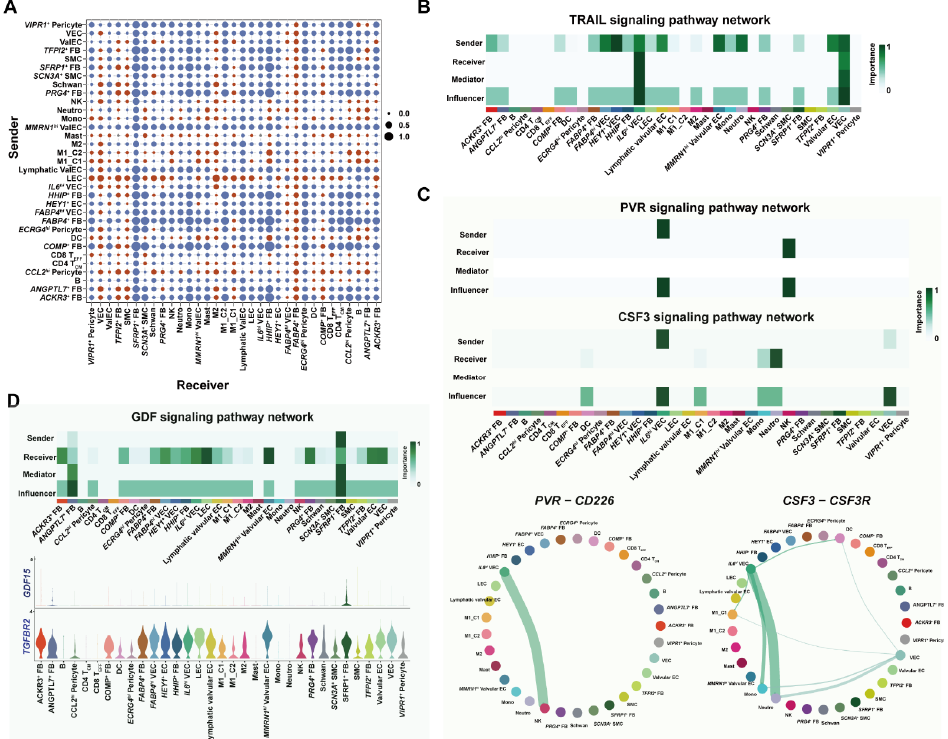
Figure 6. Cell–cell interaction analysis of all cell subsets in human GSV. ( A ) The interaction strengths among all cell subsets were compared between diabetic patient (P2) and nondiabetic patients. Red dots stand for interaction strength that was increased in P2, whereas blue dots are decreased inter- action in P2. ( B ) The plot demonstrates the signaling role of cell subsets in TRAIL signaling, and results imply that IL6 hi VECs were major receivers for this inflammatory pathway. ( C ) Heatmap represents roles of PVR and CSF signaling that were specific to diabetic venous EC subsets. Circular plot at the bottom shows the signaling strengths of ligand–receptor in PVR and CSF3 signaling path- way. ( D ) Heatmap represents roles of GDF signaling that was enriched in ANGPTL7 + FB. Violin plot at the bottom shows the GDF signaling ligand ( GDF15 )–receptor ( TGFBR2 ) in all cell subsets.